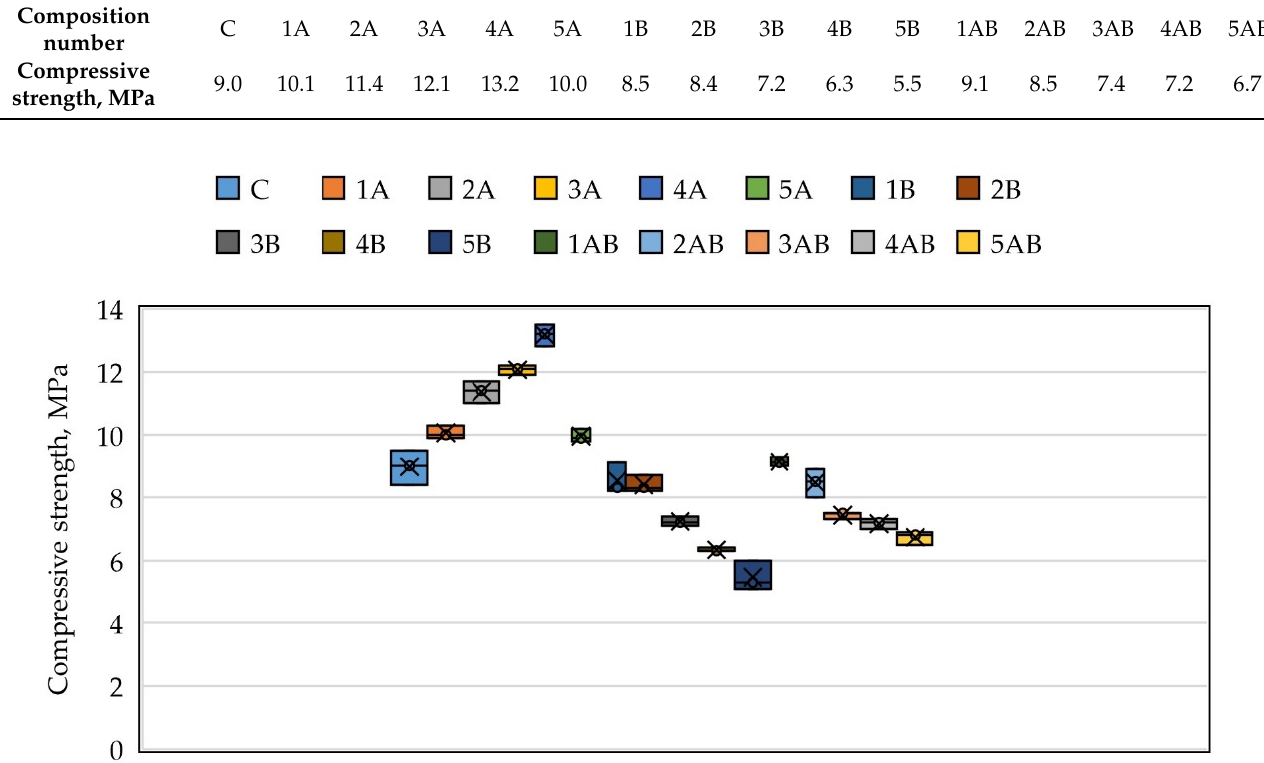
Figure 5. Statistical values of compressive strength of non-autoclaved aerated concrete.